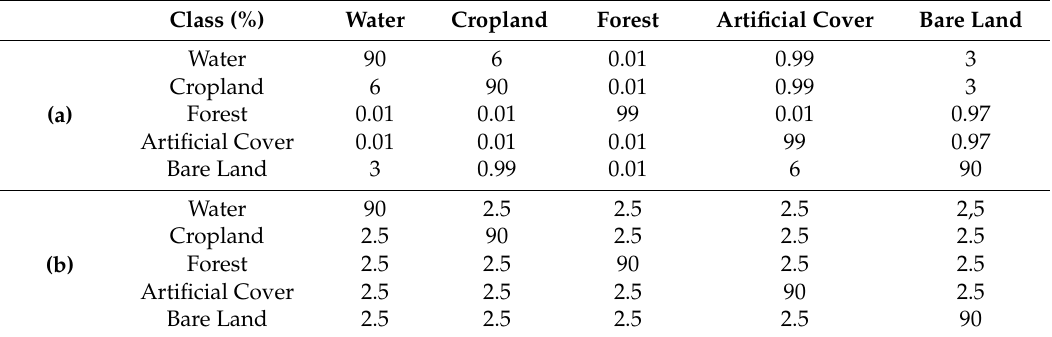
Table 2. Transition probability matrix. ( a ) defined by actual situation, marked as TRANS_1; ( b ) a simplified process, marked as